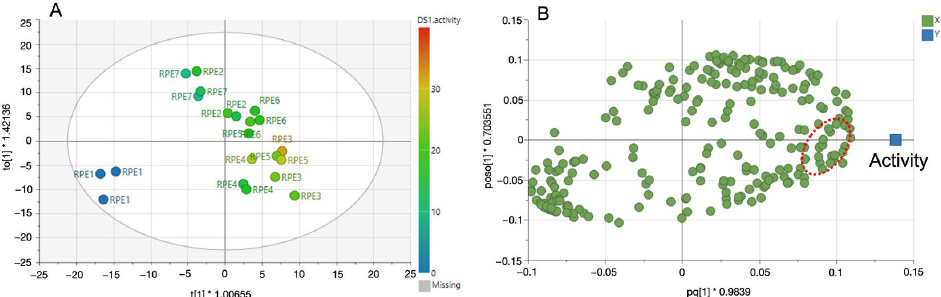
Figure 2. OPLS score plot ( A ) and loading plot ( B ) of RPEs. The scores are colored according to the TYR inhibition activity. ( A ): The label codes consist of RPE samples prepared by different extraction solvents, as described in Materials and Methods. ( B ): Loading plot presents the NMR signals (green dots) which contributed for the bioactivity (blue square). Green dots in the red circle refer to the characteristic proton NMR signals at δ 6.90 (s), δ 5.87 (d, J = 2.4 Hz), and δ 5.67 (d, J = 2.4 Hz). OPLS, orthogonal partial least squares; RPE, Rheum palmatum extract; TYR, tyrosinase.